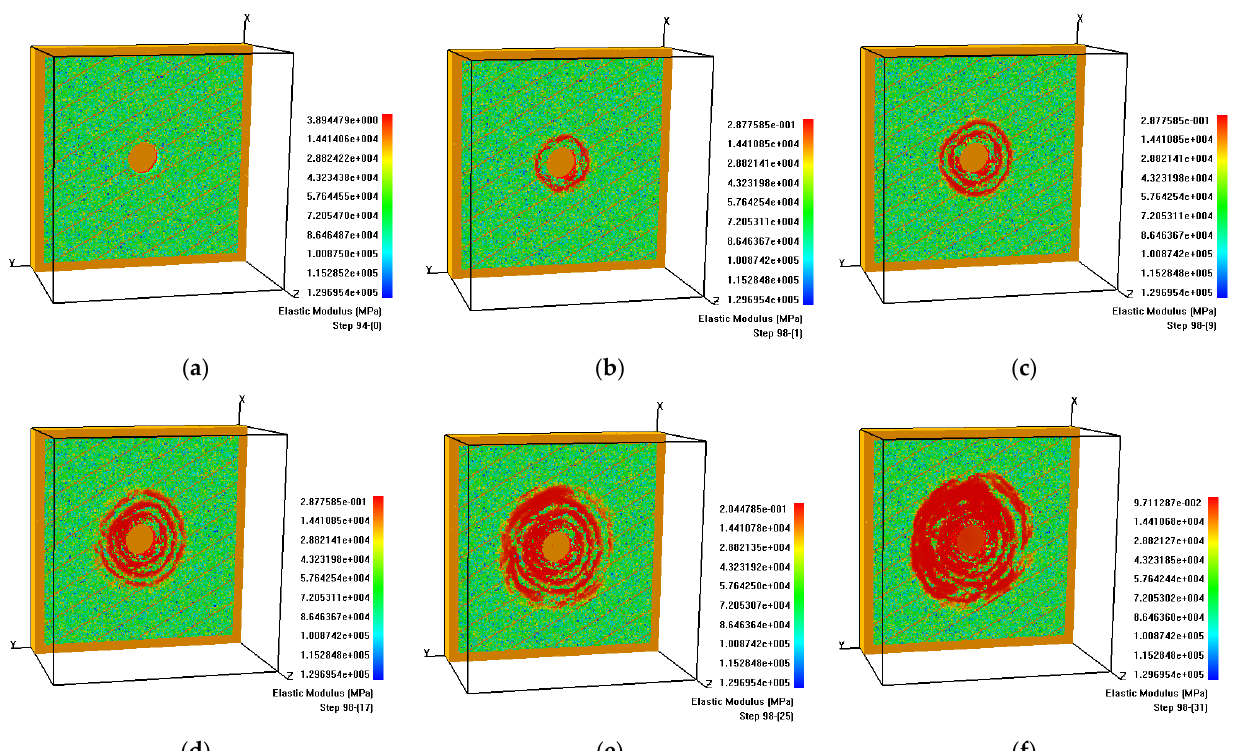
Figure 9. Distribution of elastic modulus during zonal disintegration process of surrounding rock with Model B30:( a ) Step 94-0; ( b ) Step 98-1; ( c ) Step 98-9; ( d ) Step 98-17; ( e ) Step 98-25; ( f ) Step